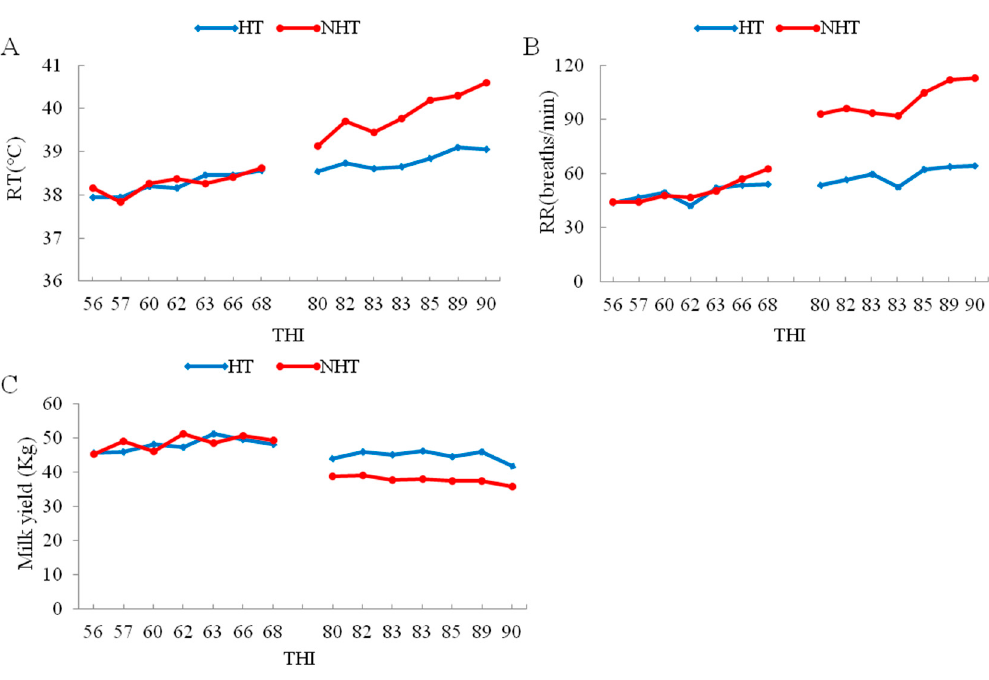
Figure 1. The change in respiratory rate (RR), rectal temperature (RT) and milk yield with increase of temperature-humidity index (THI) between HT and NHT Chinese Holstein dairy cows. ( A ) The change in RT with increase of THI; ( B ) The change in RR with increase of THI; ( C ) The change in milk yield with increase of THI. The left and right represent the changes in June and August, respectively.